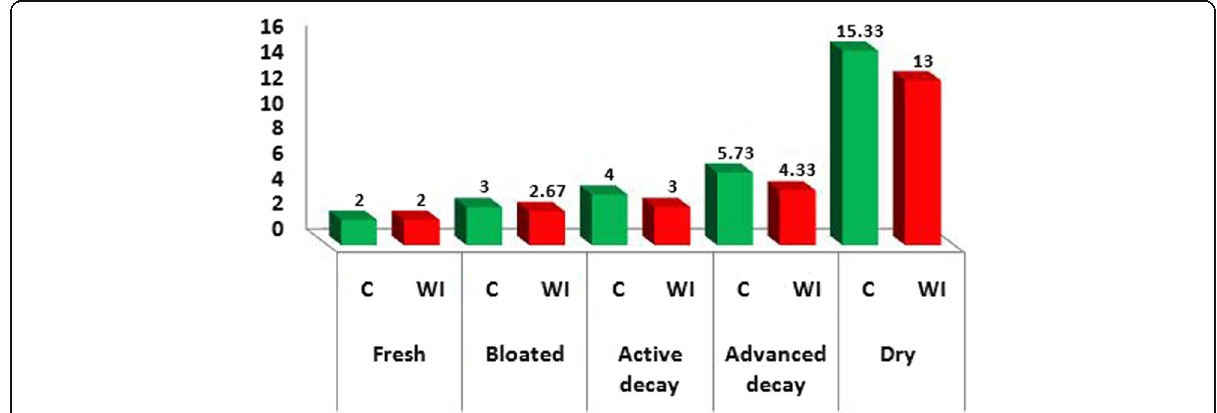
Fig. 3 Mean duration (days) of the different decomposition stages in days for control ( C ) and warfarin-intoxicated (WI)